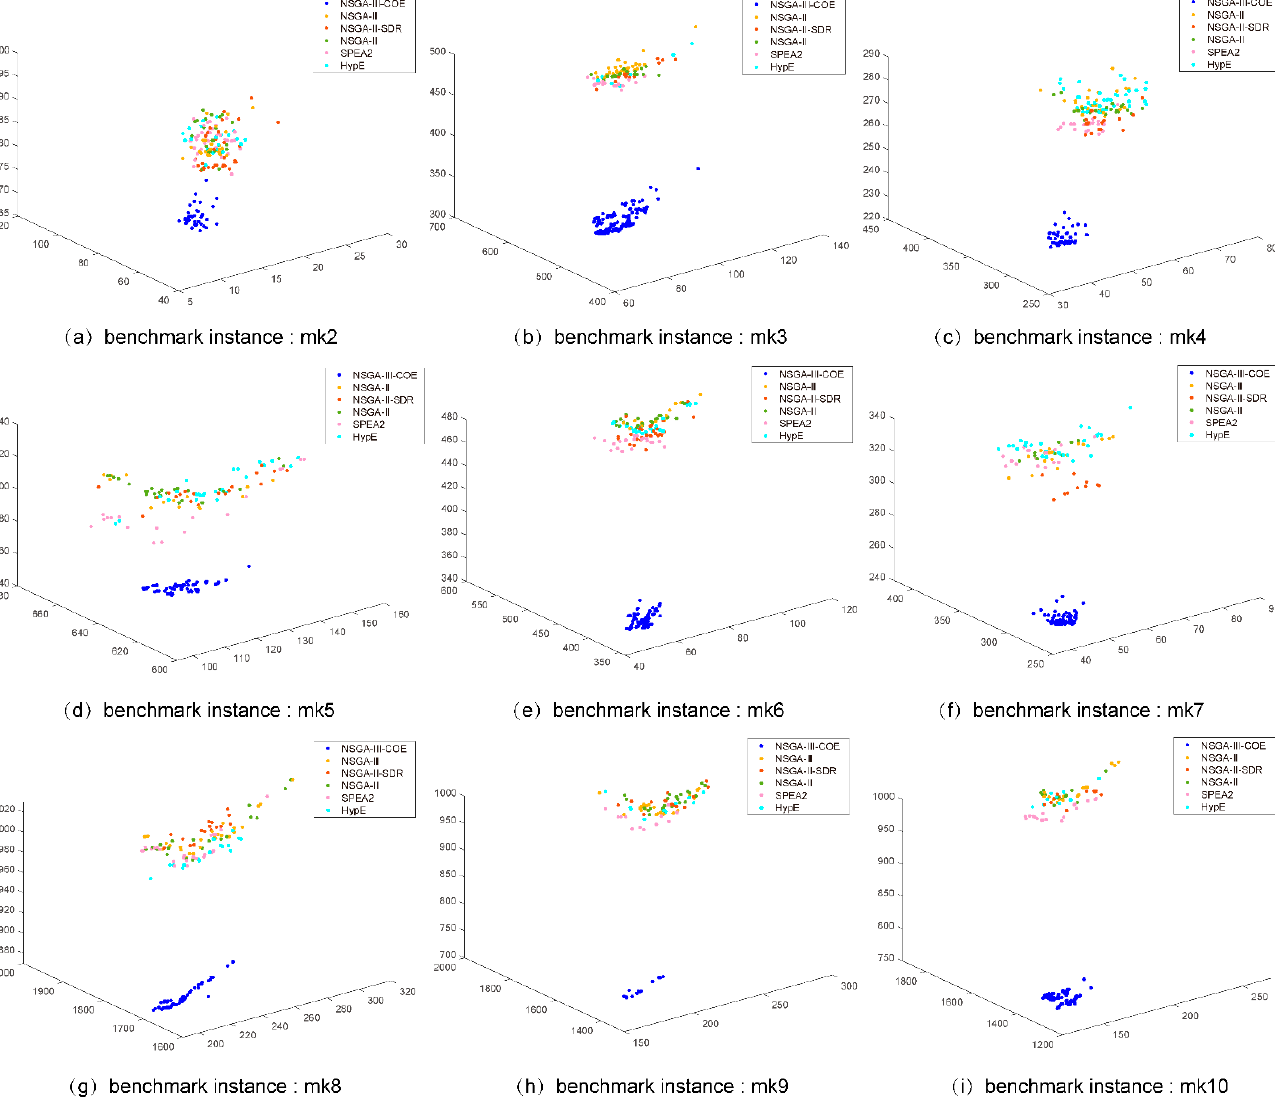
Figure 9. The non-dominated solutions of NSGA-III-COE, NSGA-III, NSGA-II, NSGA-II/SDR, SPEA2, and HypE on instances mk2–mk10.